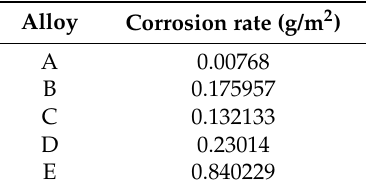
Table 3. Corrosion rate of the tested alloys after Audi test.